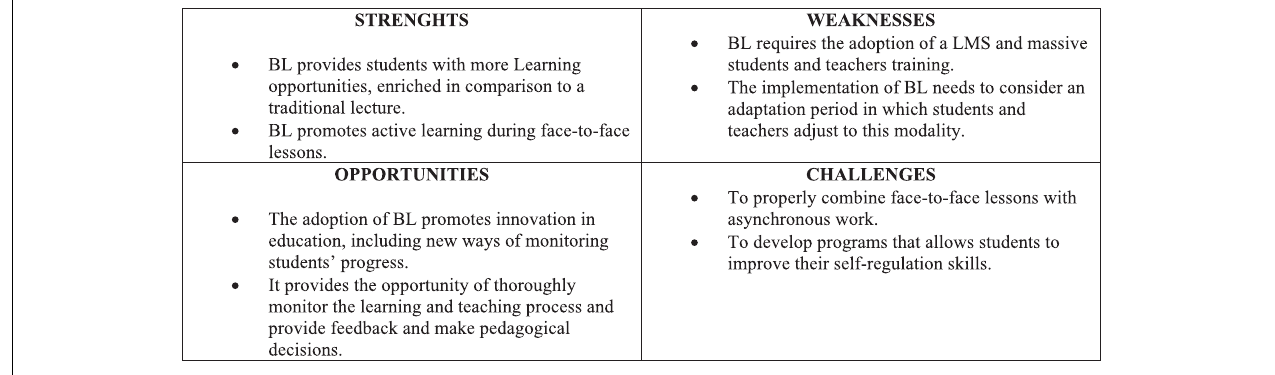
programs that allows students to improve their self-regulation skills (Broadbent,